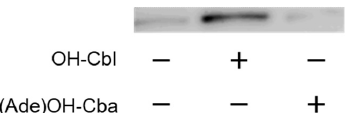
Figure 3. Western blotting of MS protein in MS cDNA-transfected cells grown with or without OH- Cbl and (Ade)OH-Cba. Cells were cultured in the medium with or without 1 µM OH-Cbl or 1 µM (Ade)OH-Cba for 2 days. Other procedures were done as shown in Figure 2. Immunoreactive bands with higher and lower molecular weights are derived from exogenous and endogenous MS proteins, respectively. Data are typical immunoreactive patterns of the MS protein from three independent Western blot analyses of treated cells.